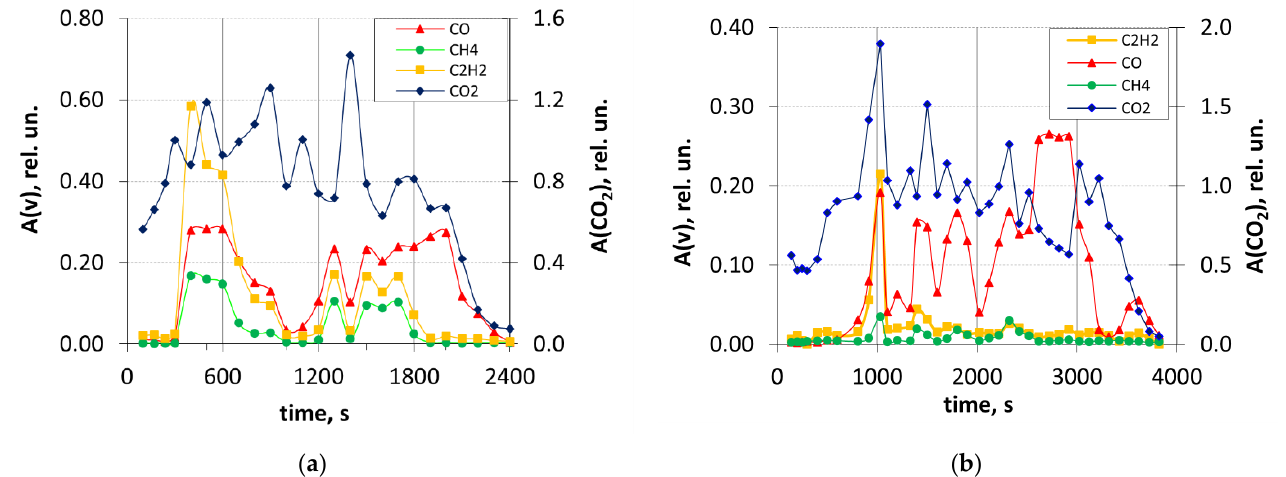
Figure 7. Yields of volatiles at different stages of the blend’s thermal decomposition: ( a ) straw* + wood and ( b ) straw* + peat.